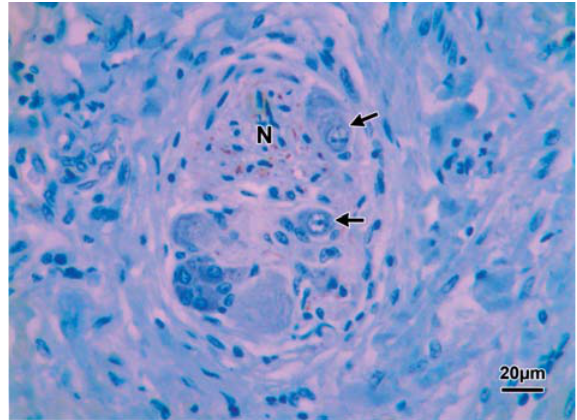
FIG. 3 NP immunonegative neuronal cell bodies (arrows) form a ganglion in the ovarian stalk. Closely associated with the neuronal cell bodies is a NP immunopositive nerve bundle (N)